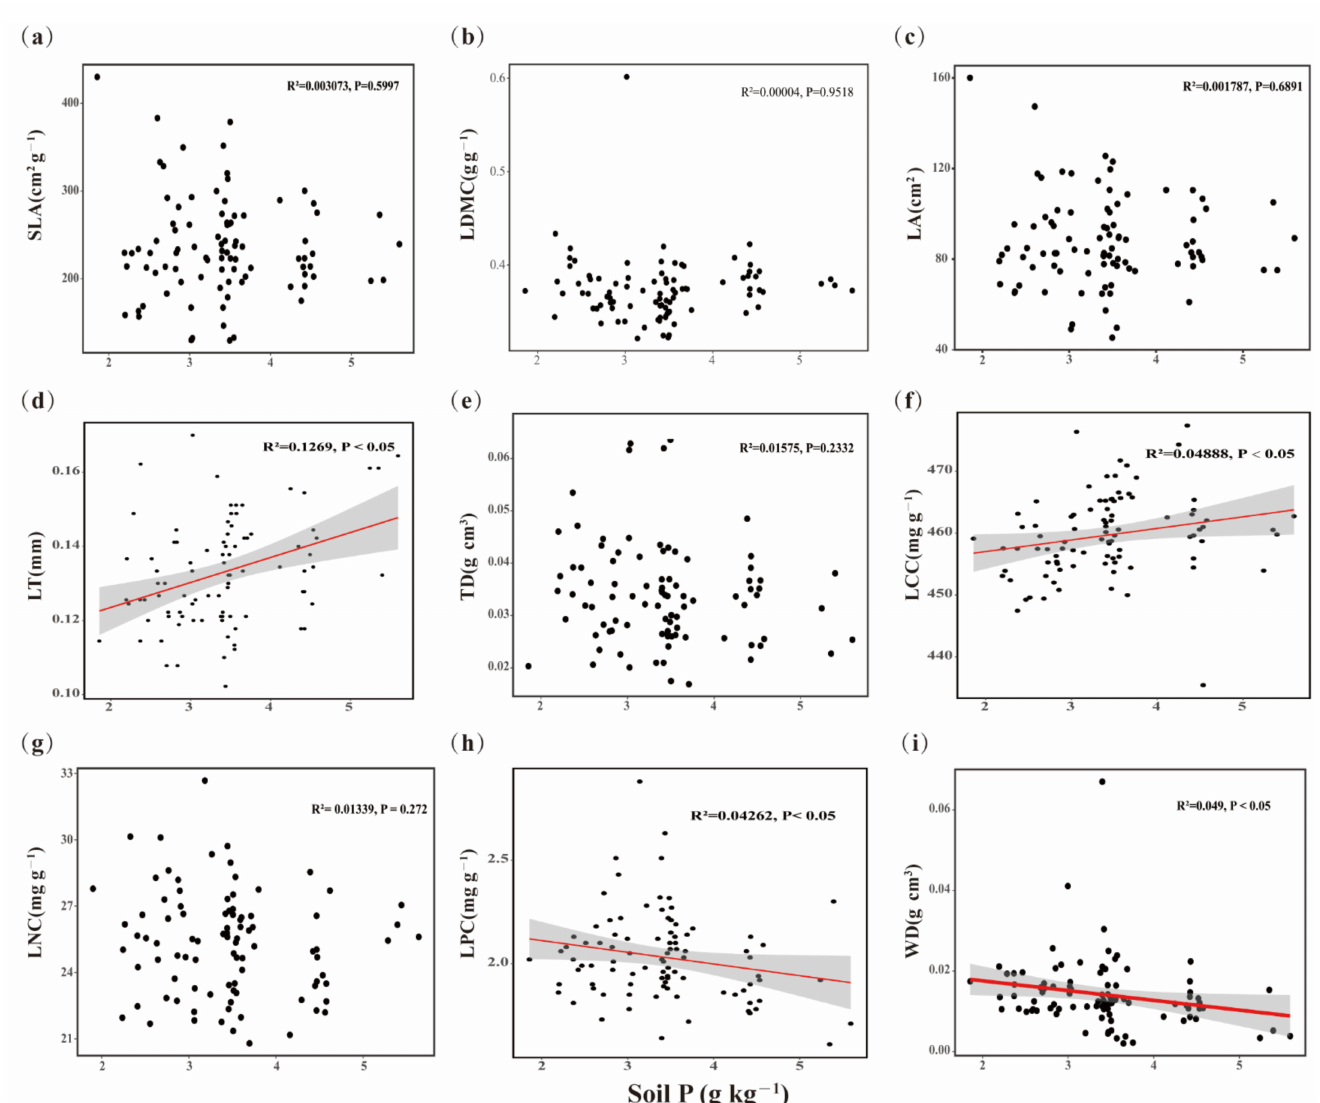
Figure 3. The effects of soil P on functional traits ( a – i ). The shaded regions indicate 95% confidence intervals of the predicted values. Trait abbreviations: SLA (specific leaf area); LDMC (leaf dry matter content); LA (leaf area); LT (leaf thickness); TD (leaf tissue density); LCC (leaf carbon concentration per unit leaf mass); LNC (leaf nitrogen concentration per unit leaf mass); LPC (leaf phosphorus concentration per unit leaf mass); and WD (wood